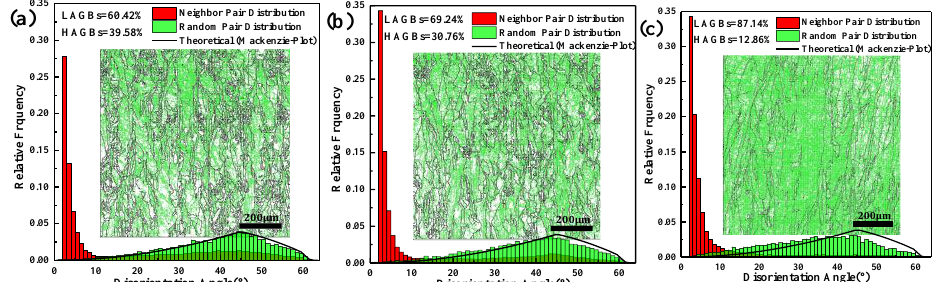
Figure 9. The distribution of LAGBs, neighbor pair and random pair at different VEDs: ( a ) VED = 60 J·mm −3 ; ( b ) VED = 96 J·mm −3 ; ( c ) VED = 119 J·mm −3 .